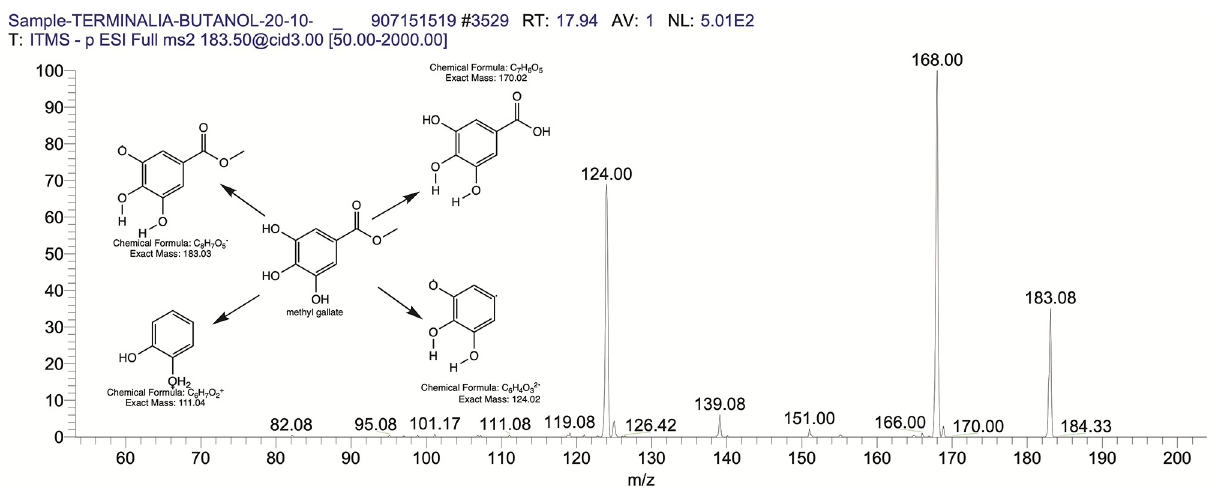
Fig 15. The mass spectrum of methyl gallate and its fragmentation pattern.